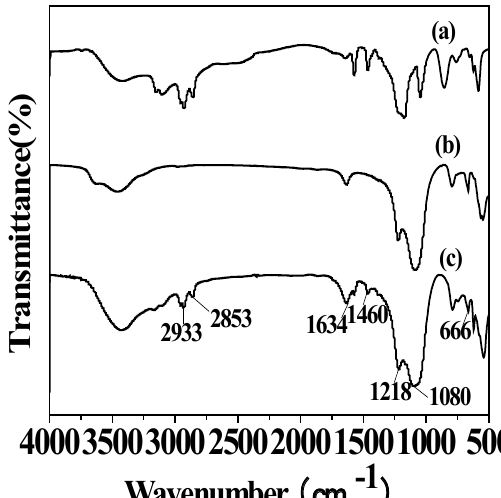
mimHSO ionic liquid, (b) Co/ZSM-5 7 4